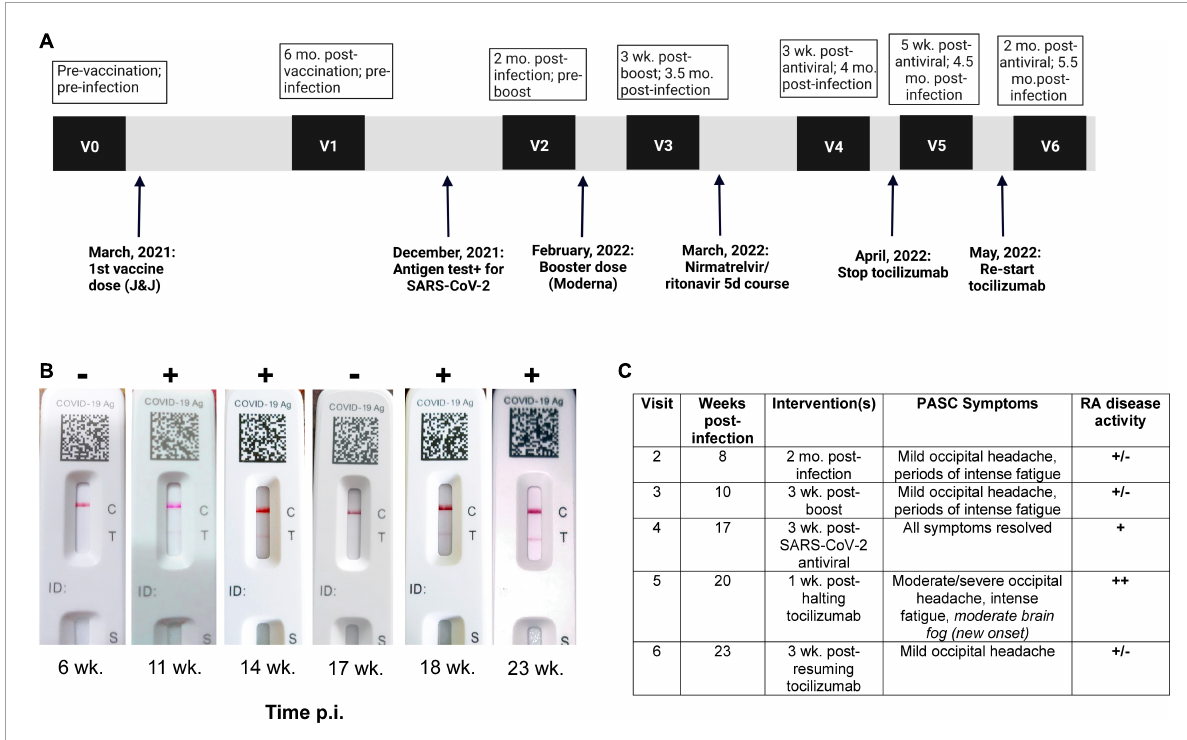
FIGURE1 Post-acute sequelae of SARS-CoV-2 infection (PASC) patient exhibits persistent SARS-CoV-2 antigen positivity in nasopharynx. (A) Study visit timeline, including vaccination, infection, and intervention dates. (B) FlowFlex TM SARS-CoV-2 antigen test results over time. Time p.i., weeks post-infection. (C) PASC symptoms vs. rheumatoid arthritis symptoms.